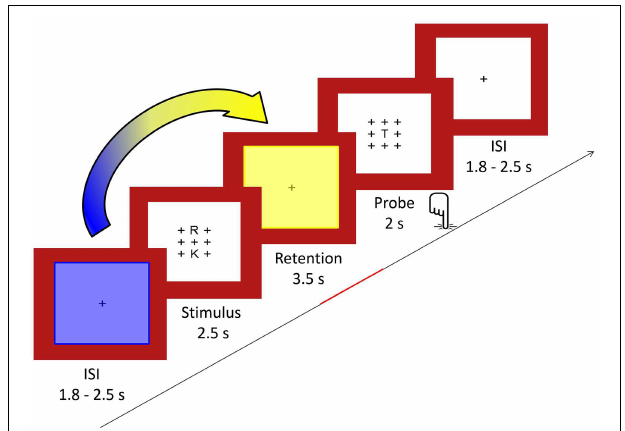
FIGURE 1 | In the Sternberg WM task, sets of either two or five consonants were presented for 2.5s (stimulus) and had to be retained in memory for 3.5s (retention). Subsequently, a probe letter was shown for 2s (retrieval). Subjects indicated by button press whether the probe had been part of the stimulus. As indicated by the arrow, we computed covariance mappings between pre-stimulus percent TCN-activity fluctuations (period marked in blue) and EEG spectral fluctuations from the last 2.5s of the retention period (period marked in